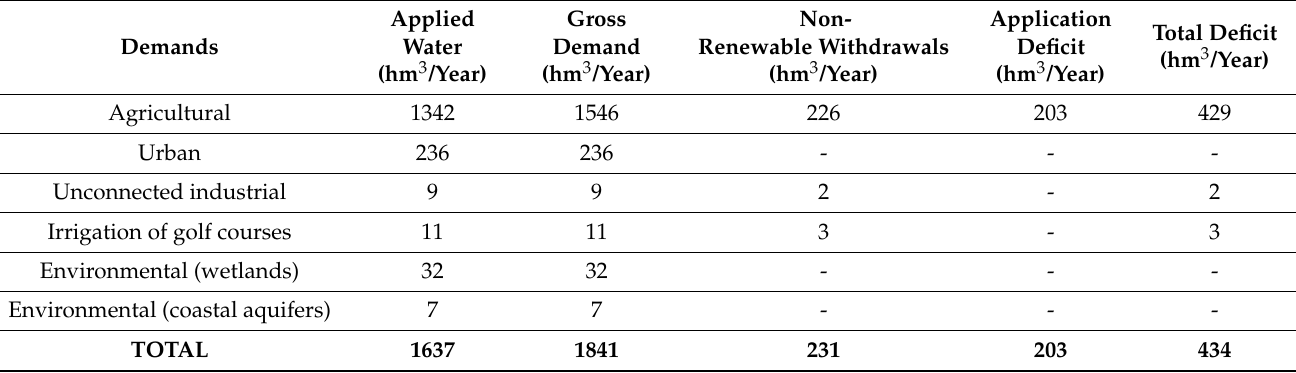
Table 8. Deficit SBHP 2015/21, on the 2015 horizon. Source: own elaboration based on [34,61].